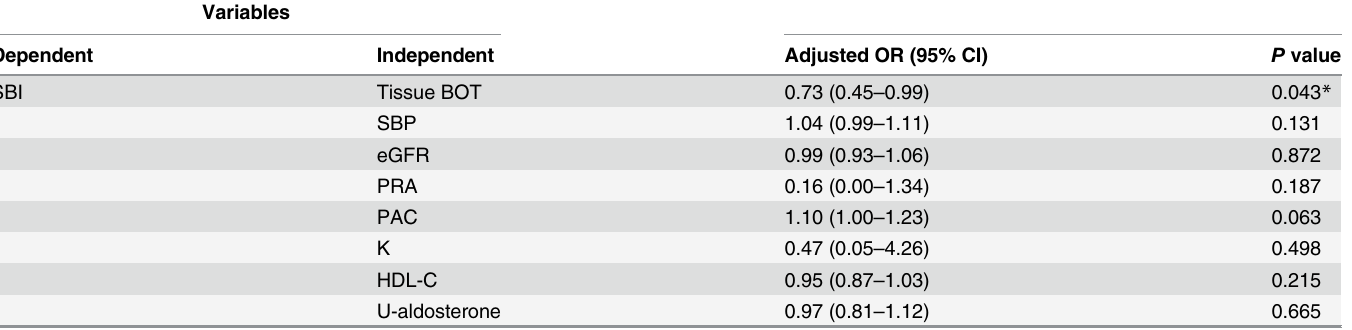
Table 3. Logistic regression analysis of independent variables affecting the presence of silent brain infarction in primary aldosteronism patients.